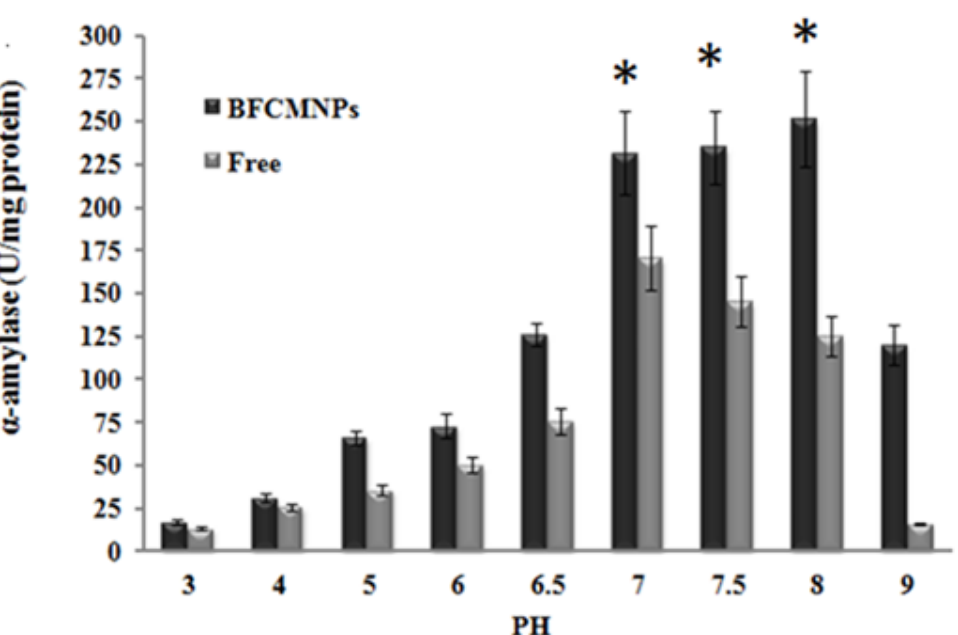
Figure 9. Effect of pH on the specific activity of free and immobilized alpha-amylase-BFCMNPs; * p ≤ 0.05.